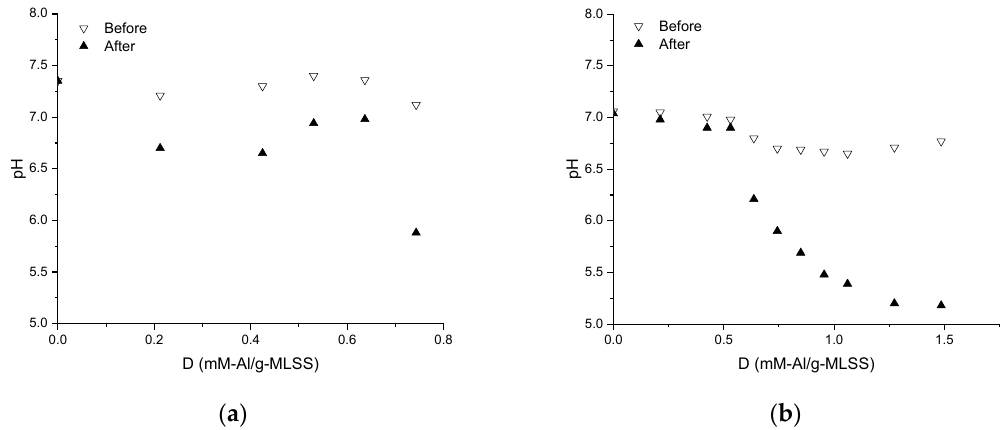
Figure 4. Influence of chemical enhancer dose on supernatant pH after dosing into Mixed Liquors from MBBR ( a ) and IFAS ( b ).